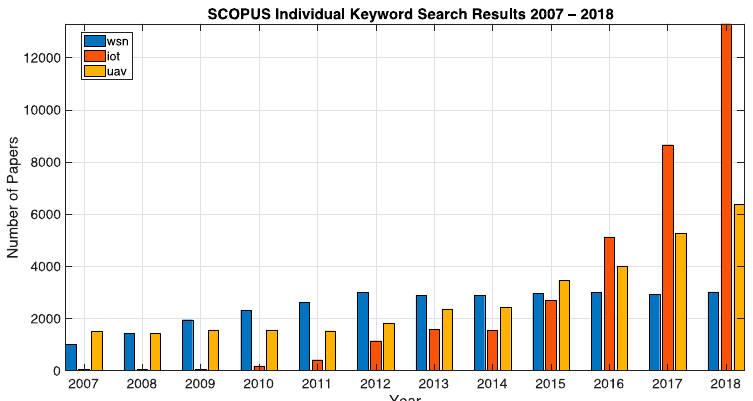
Figure 2. SCOPUS search results on keywords between 2007 and 2018: UAV, WSN and Internet of things (IoT), separately.